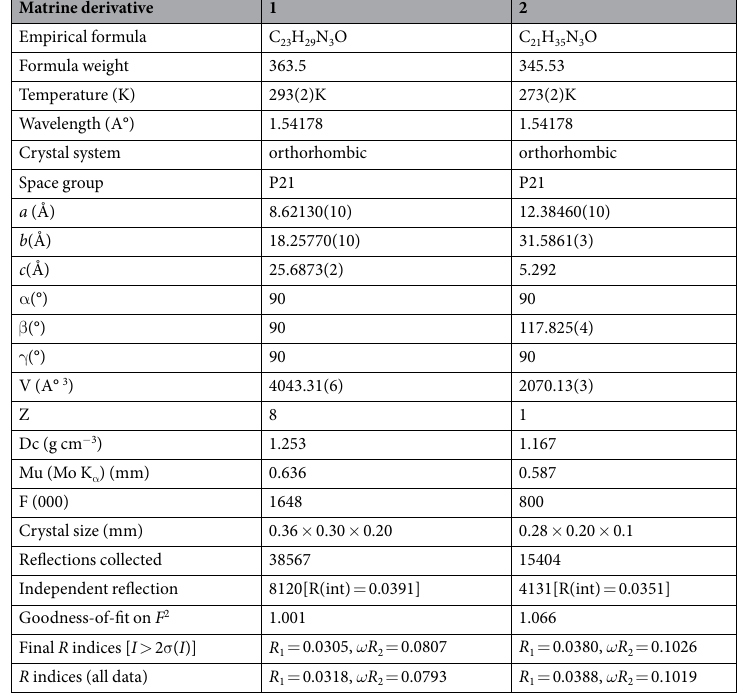
Table 1. Crystal and structure refinement data of matrine derivatives 1–2.